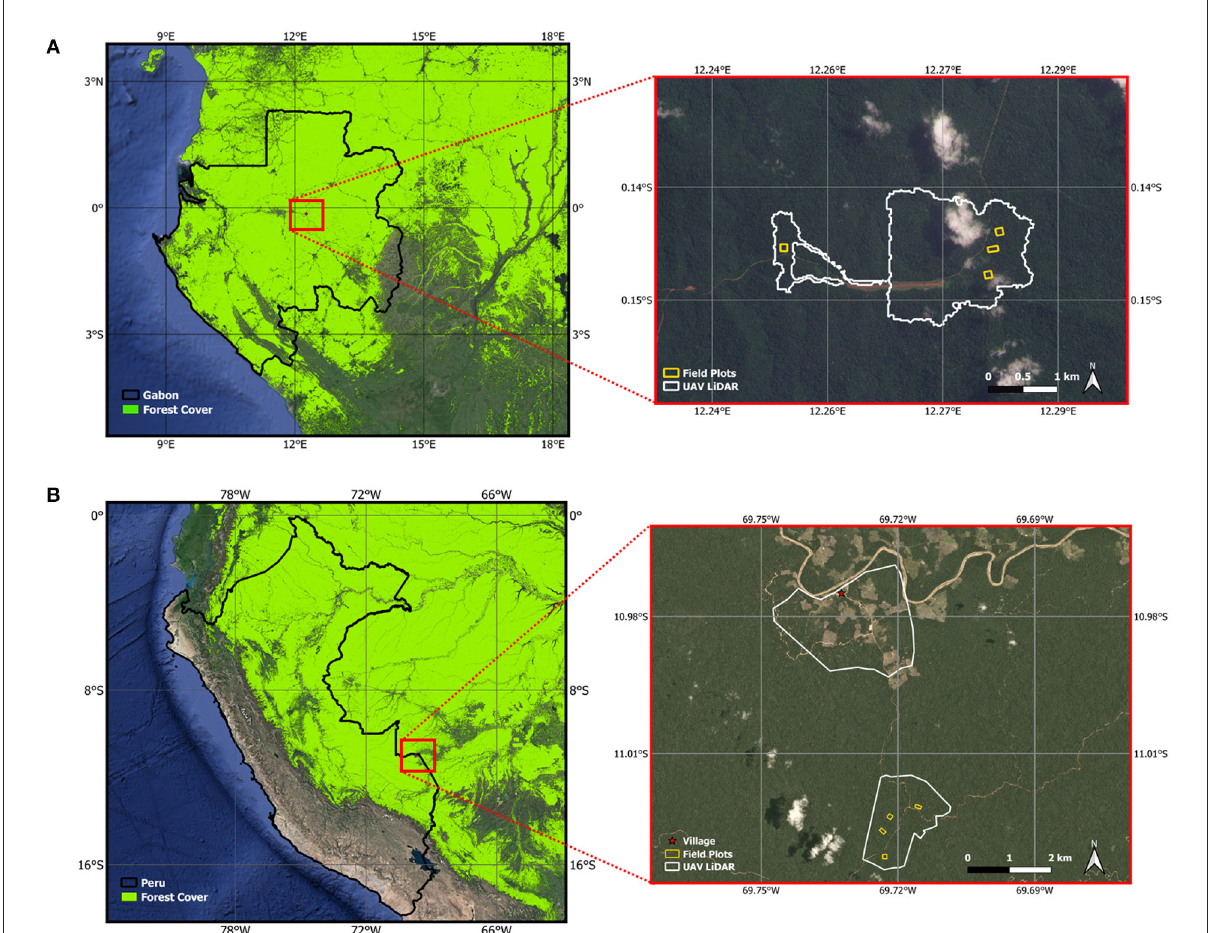
FIGURE1 Location of the two study areas in (A) Gabon and (B) Peru. The left panels show the position of the field sites within the country boundaries. The layer in bright green is the primary humid tropical forest extent for the year 2001 from Turubanova et al. (2018). The right panels show the location of the forest plots (yellow boxes) and the area covered by the UAV LiDAR acquisitions (white). Both RGB images of the field sites date to May 2022 and are 3 m PlanetScope images acquired through Planet’s Education and Research Program (Planet Team,